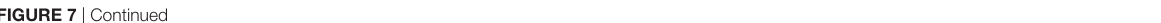
FigUre 7 | Continued Assessments of direct and Fc-mediated effects of anti-HER2 Fc variants against breast cancer cells. (a) Effects of anti-HER2 antibody variants on the proliferation of trastuzumab-sensitive (BT-474, SK-BR-3), trastuzumab-resistant (HCC1954) and triple-negative (MDA-MB-231) breast cancer cell lines. Anti-HER2 variants inhibited the proliferation of BT-474 and SK-BR-3 cells in a similar dose-dependent manner, but did not affect the proliferation of MDA-MB-231 or HCC1954 cells. Graphs represent an average of two experiments ± SD. (b) Human peripheral blood NK cell-mediated ADCC of BT-474 cancer cells induced by anti-HER2 variants measured by LDH release. Graphs are representative of independent experiments with three different human NK cell donors; data were normalized to minimal and maximal cell lysis. Error bars represent SEM values from technical replicates. N/D: not detected. (c) Effective concentration [(EC50) nM] measurements of ADCC by three human NK cell donors. (D) NK cell-mediated ADCC (measured by LDH release) of HER2 low (MDA-MB-231) and HER2 high (BT-474) breast cancer cells induced by anti-HER2 variants. The flow cytometric histograms on the left depict HER2 expression levels in MDA-MB-231 (top) and BT-474 (bottom) compared to unstained cells or cells stained with isotype control mAb. The graphs represent total cell killing levels of MDA-MB-231 cells (top) and BT-474 cells (bottom) mediated by NK cells from two different donors (Donors 4 and 5) at different concentrations of anti-HER2